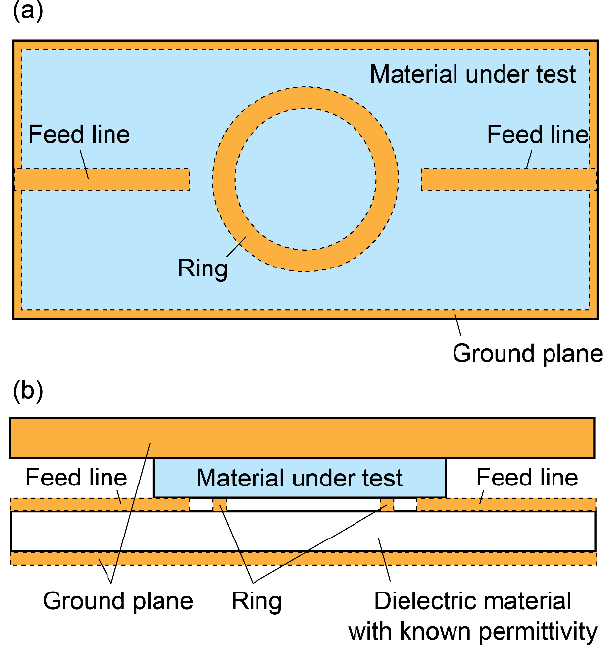
Figure 13. Schematic illustration of a strip line ring resonator for dielectric characterization: ( a ) top and ( b ) cross-sectional views. Redrawn from [97] (p. 2).